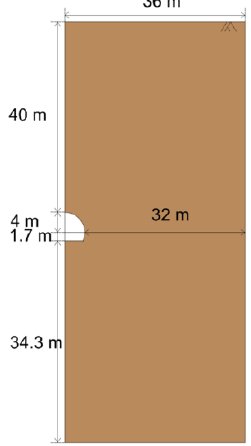
Figure 3. Cross section of the numerical analysis.